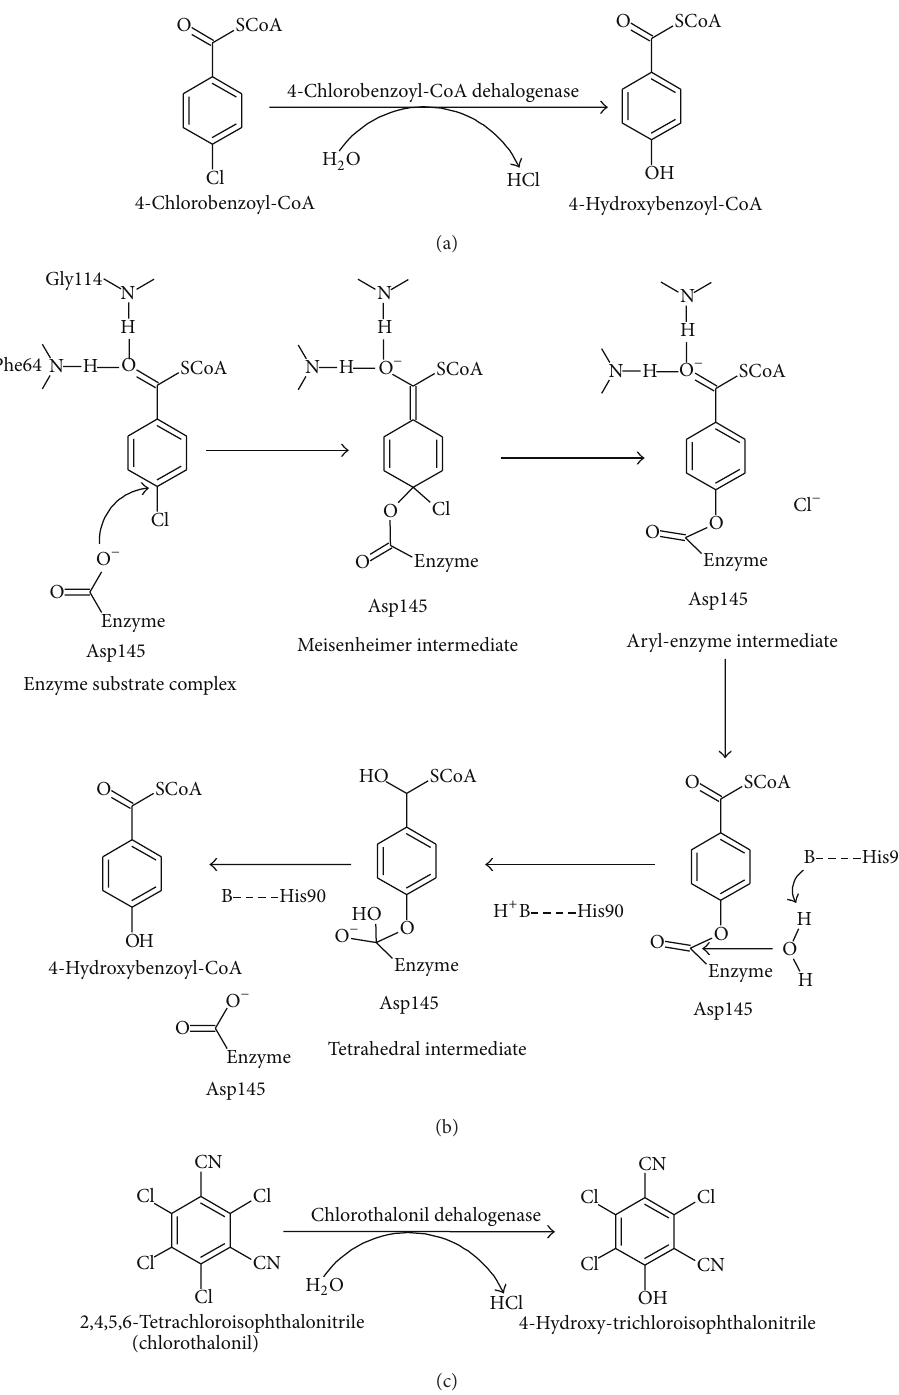
Figure 1: Hydrolytic dehalogenation. (a) Conversion of 4-chlorobenzoyl-CoA to 4-hydroxybenzoyl-CoA with release of chloride ion by a 4-chlorobenzoyl-CoA dehalogenase. (b) Mechanism of 4-chlorobenzoyl-CoA dehalogenase. (c) Hydrolytic dehalogenation of chlorothalonil by a chlorothalonil